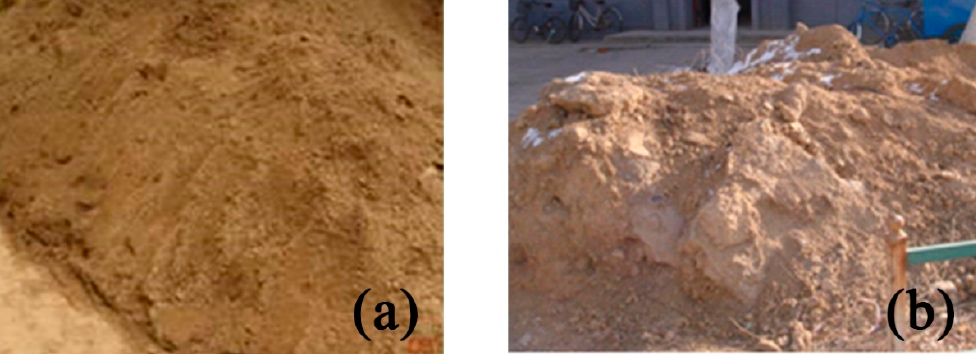
Figure 3. Medium sand and silt: ( a ) medium sand; ( b ) silt.